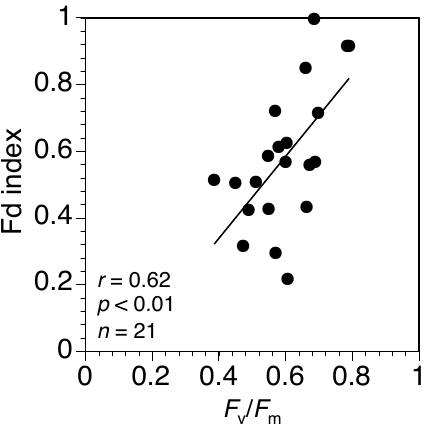
Fig. 12. A relationship between F v / F m values for total micro-sized phytoplankton and the Fd index values for micro-sized diatoms in surface waters off Sakhalin Island. A linear regression line is plotted with the